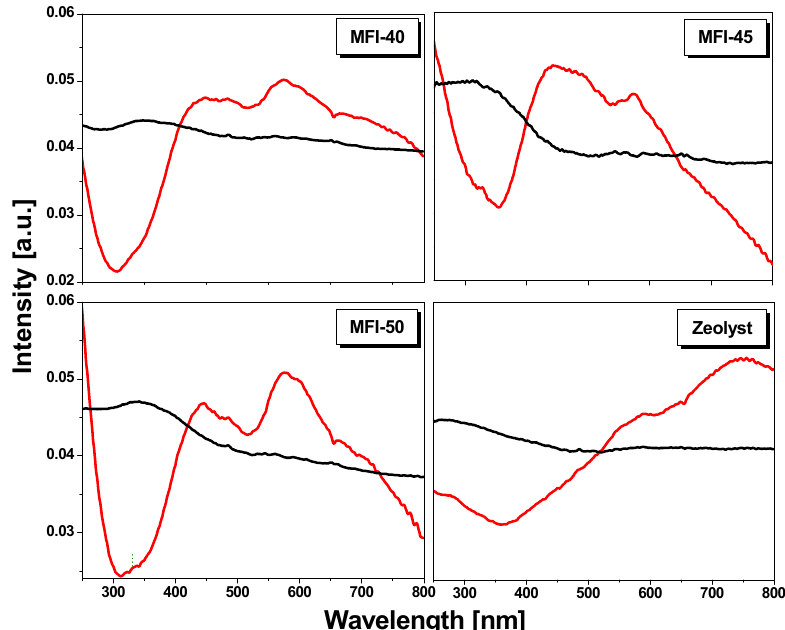
Figure 8. UV-vis Eigen spectra of investigated samples. Red colored spectra represent the active species, while black colored spectra represent the deactivated species, as determined by the NNMF method from operando UV-vis spectra.